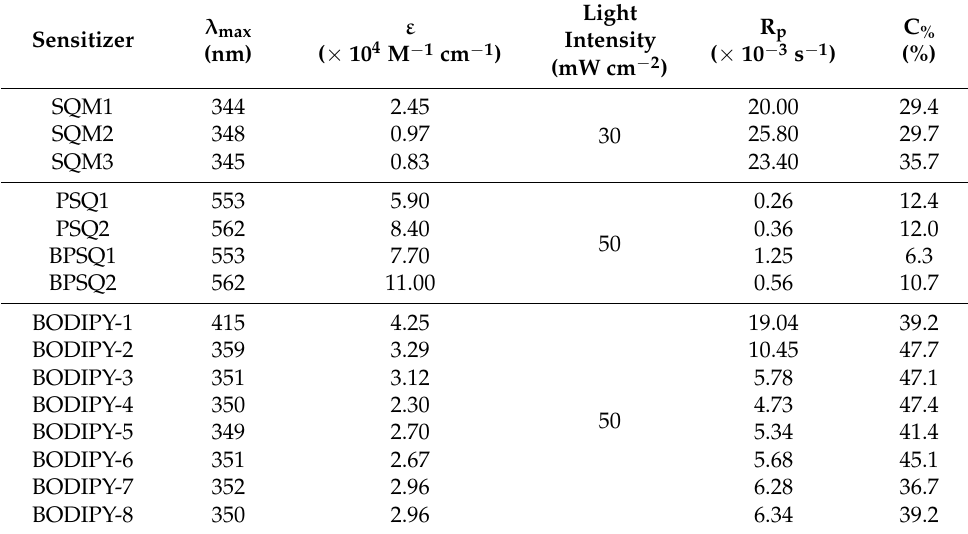
Table 1. Summary of the spectroscopic properties of photosensitizers and the kinetic parameters of the radical polymerization of